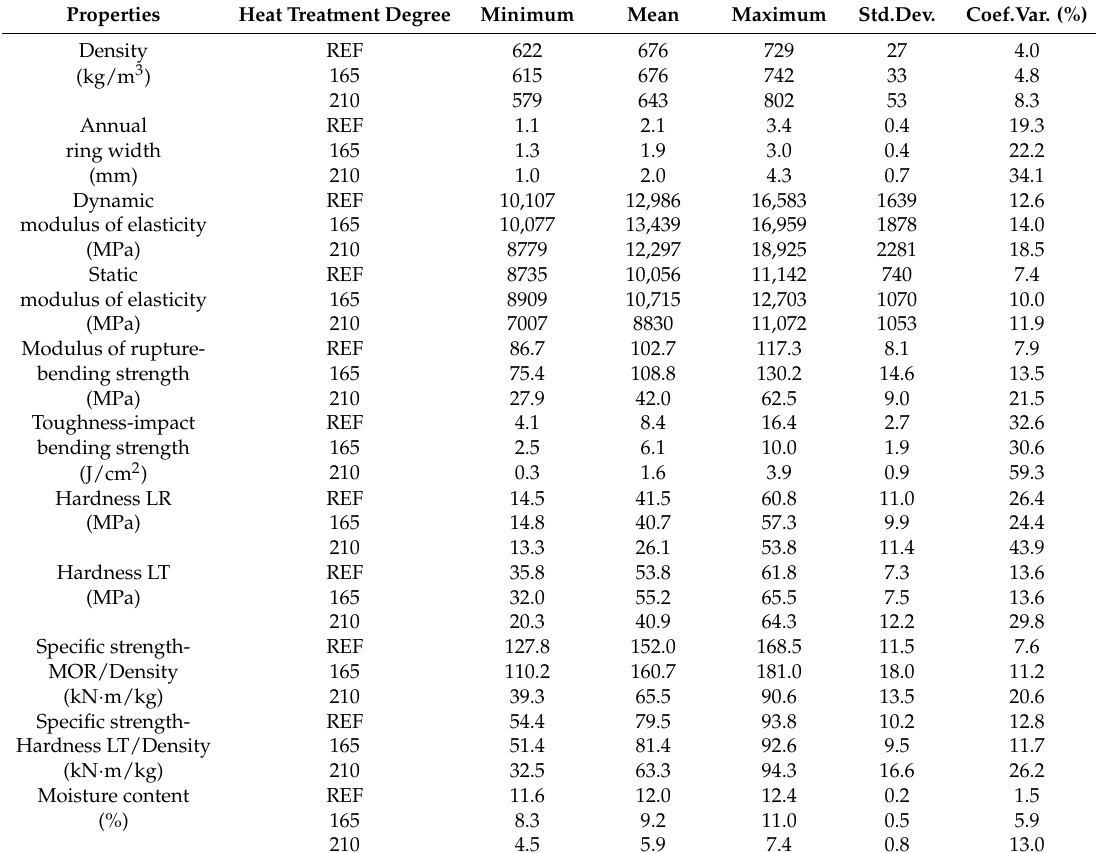
Table 3. Basic Statistical Analyses of the Properties for Untreated and Heat-Treated Beech Wood. Properties